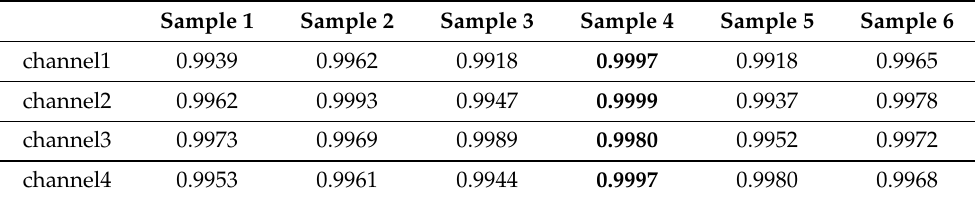
Table 4. SSIM comparison results of generating halftone and original halftone.